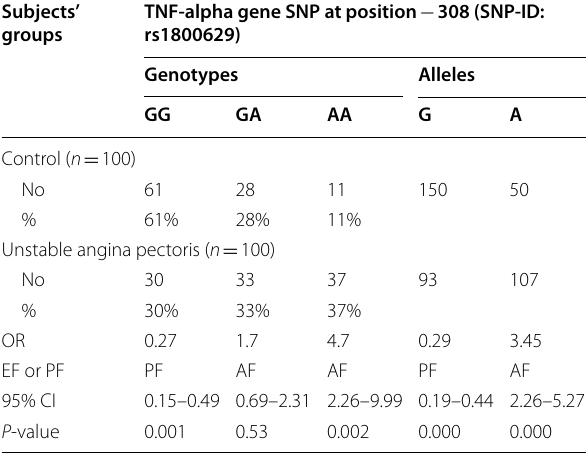
OR , odd ratio; AF , attributable fraction in population; PF , prevented fraction in population; P , Fisher’s exact probability